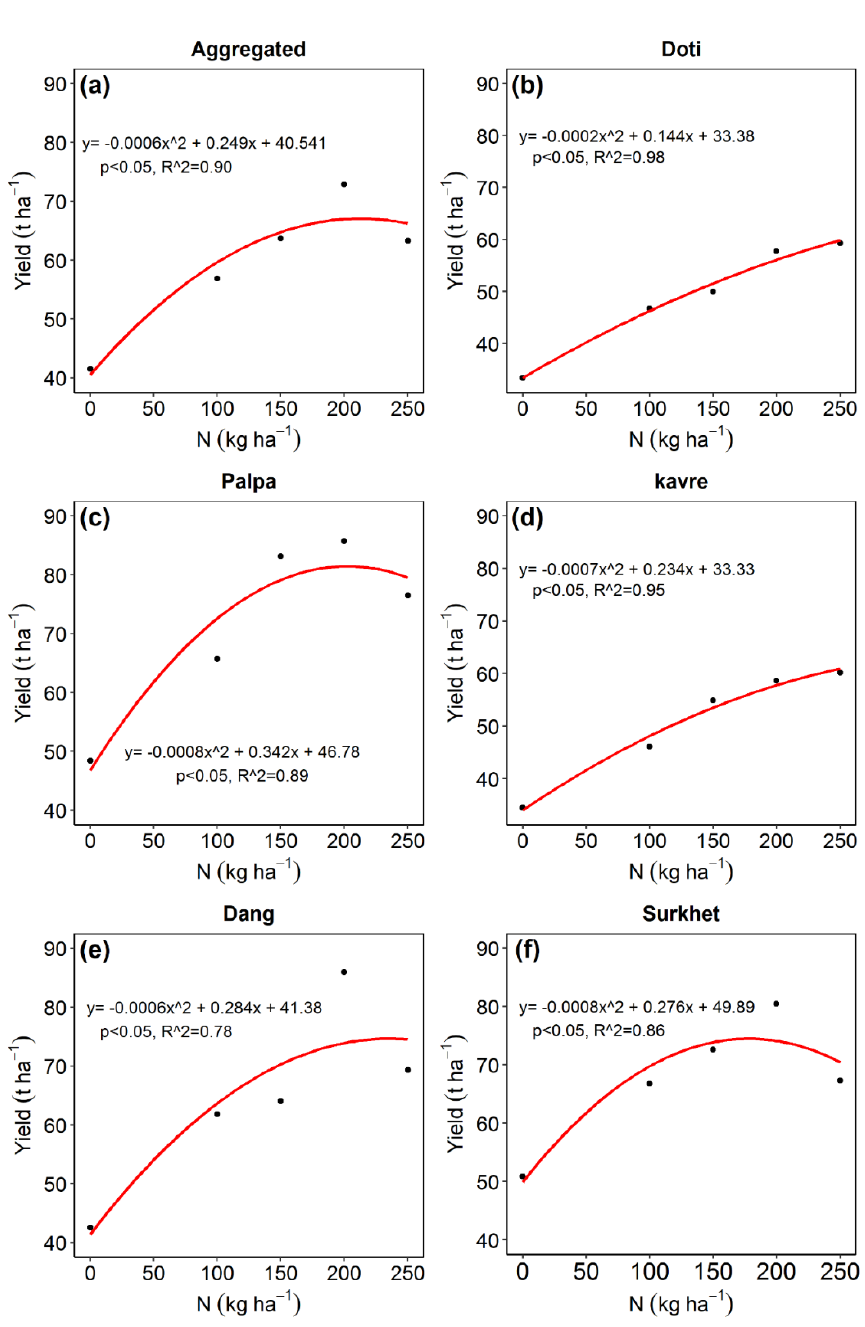
Figure 4. Relationship between nitrogen fertilizer applied at five different rates and tomato yield across aggregated districts (a) and disaggregated by districts: Doti (b), Palpa (c), Kavre (d), Dang (e) and Surkhet (f). Each data point for aggregated and disaggregated districts is the average of five different N rates.